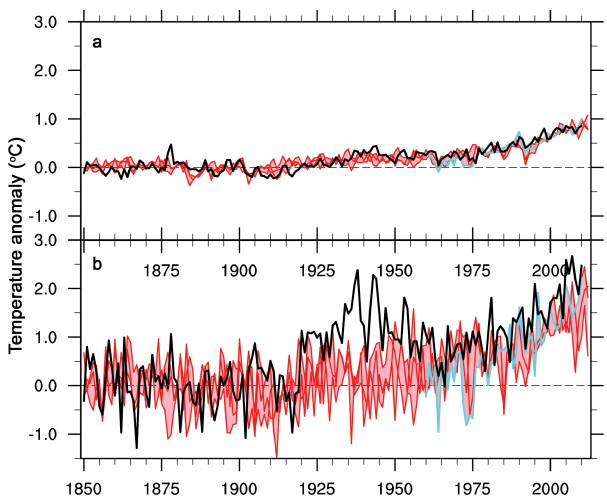
Fig. 24. Annual mean observed (thick black line) and simulated (red and cyan lines) T2m anomalies ( ◦ C) relative to the period 1850–1899 for global temperature (a) and temperature poleward of 60 ◦ N (b) . Observations from HadCRUT4 (1850–2010; Morice et al., 2012) and simulations from the three historical members. Historical1 is, for illustrative purposes, shown with cyan colour for the period 1961–2010.